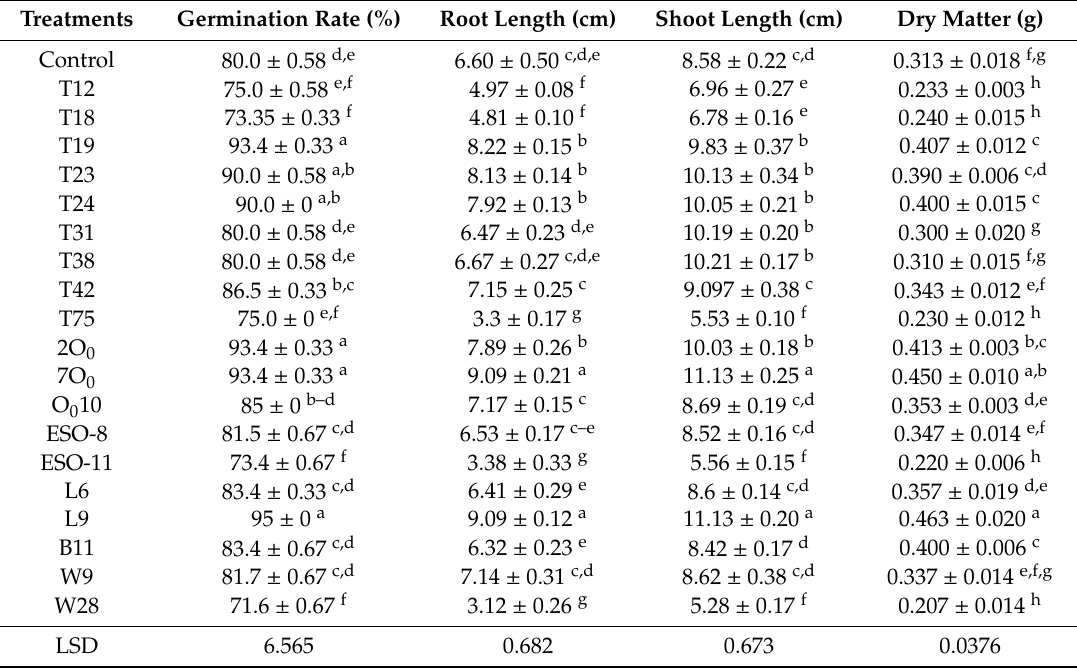
Table 5. The e ff ect of presumed allelopathic bacteria on the germination and seedling growth of wheat. Values sharing the same letter(s) in a column do not di ff er significantly from each other at p < 0.05. Values in a column indicate mean ± standard